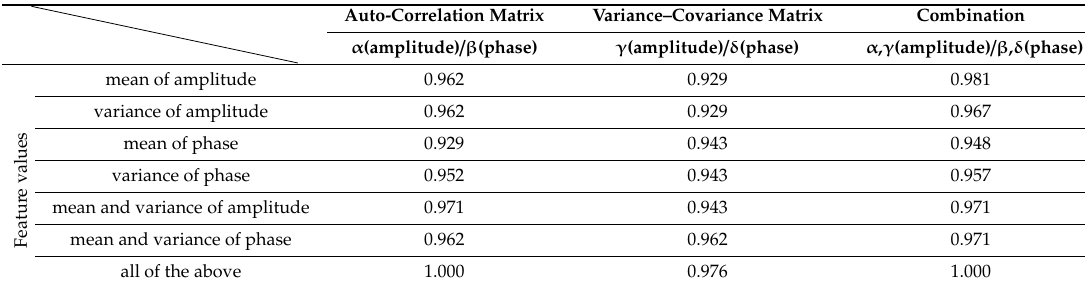
Table A1. Prediction accuracy for two directions when using the length of the final passing section and CSI. The machine learning algorithm is random forest. The values denote the predicted